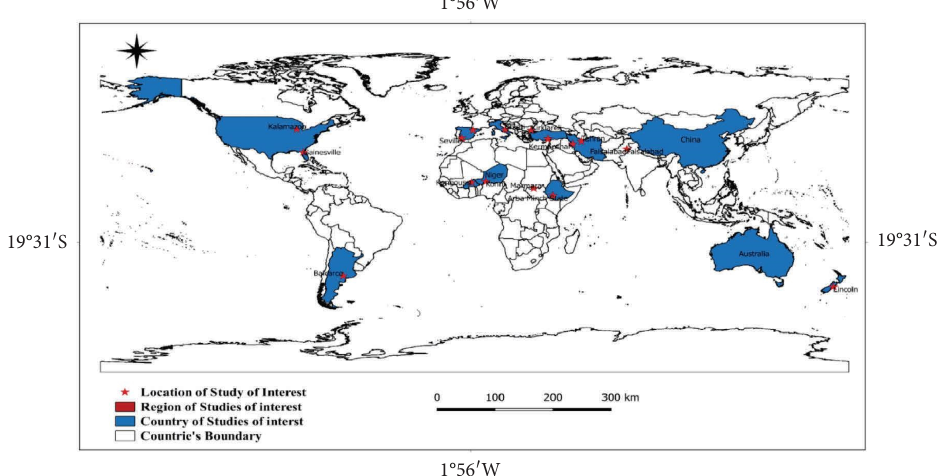
Figure 1: Distribution of locations of studies accounted for in this review.